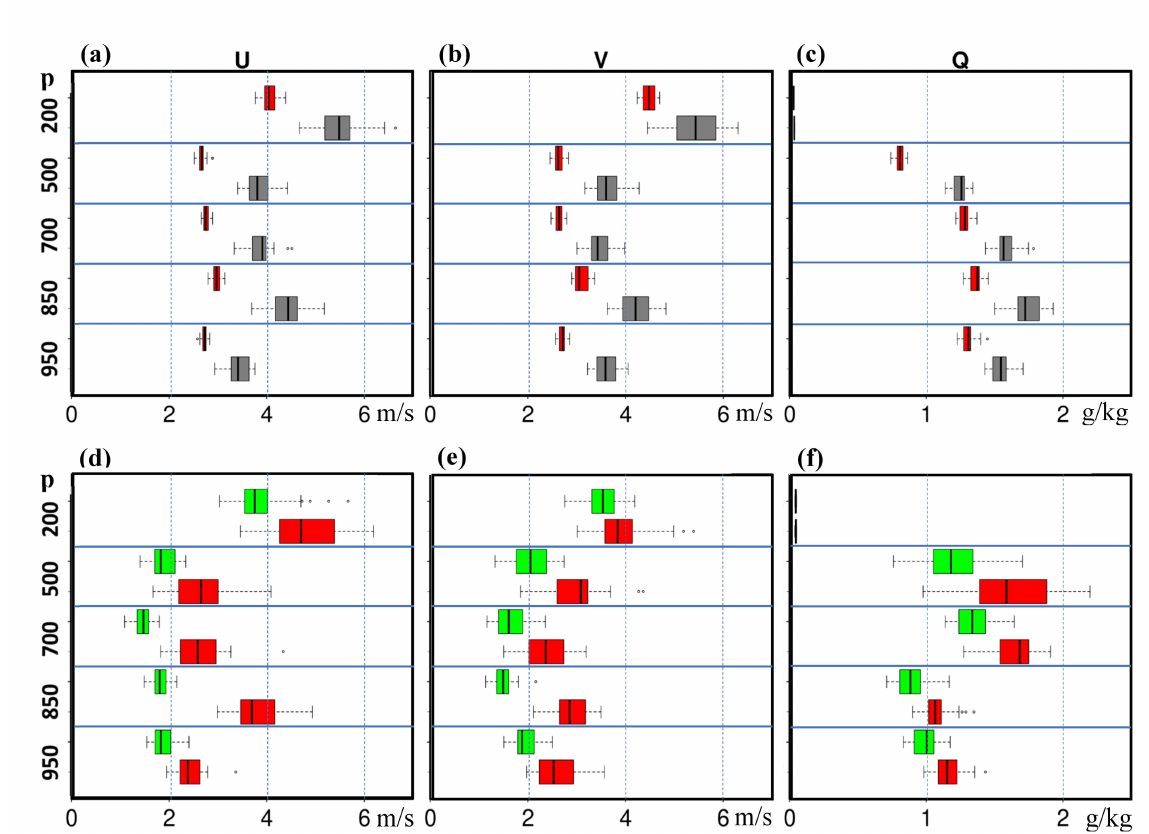
Figure 10. Box plots of the RMSEs of ( a ) the east–west wind component (u, m s − 1 ), ( b ) the north–south wind component (v, m s − 1 ), and ( c ) the mixing ratio (q, g kg − 1 ) averaged over the land area of domain 1 at 950, 850, 700, 500, and 200 hPa for the 32 ensemble members of NODA (gray) and CTRL (red) at 0000 UTC 31 July 2017 using NR as the truth. The box extends from the first quartile to the third quartile (interquartile range), with a line denoting the median value. The upper/lower error bars show the data value that is 1.5 × the interquartile range above/below the third/first quartile. The dots are outliers. ( d – f ) Same as ( a – c ) but for CTRL (red) and T5D12 (green). The RMSEs were averaged over the northern SCS area shown as a yellow box in Figure